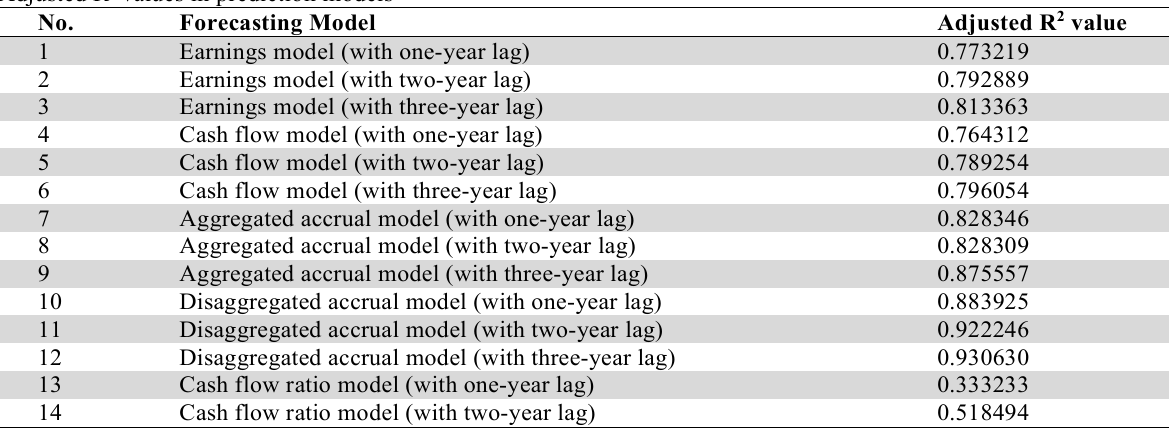
Adjusted R 2 values in prediction